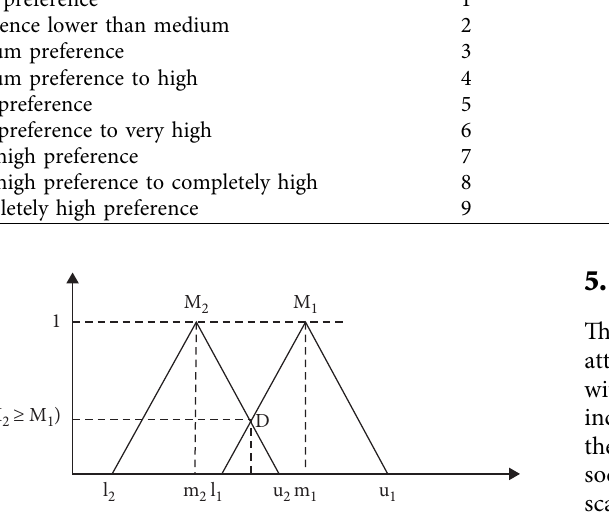
Figure 2: Pairwise comparison of triangular fuzzy